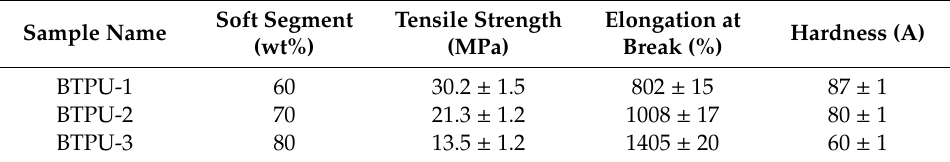
Table 3. Some mechanical properties of various BTPUs.